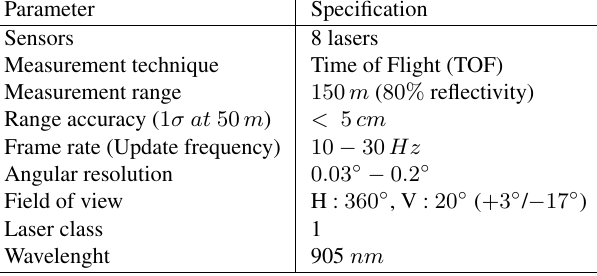
Table 1: Datasheet provided by